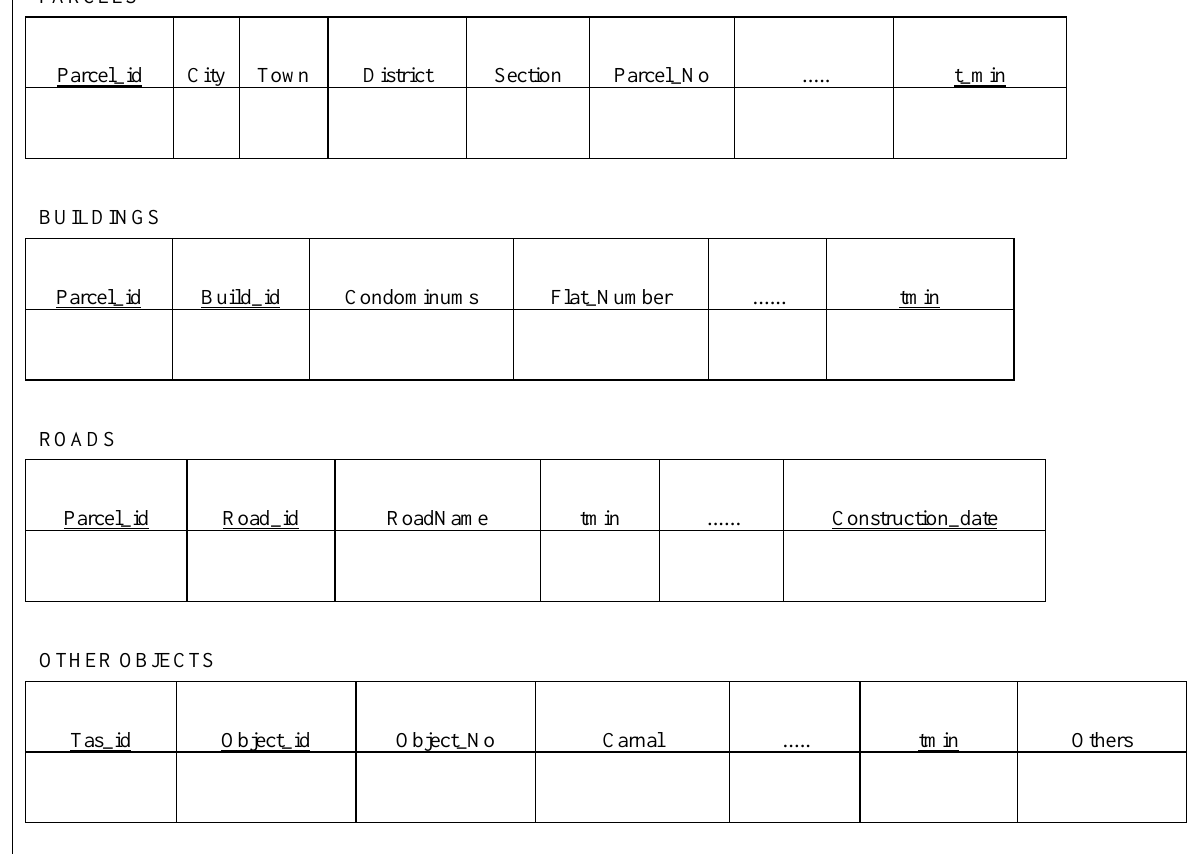
(reference vector